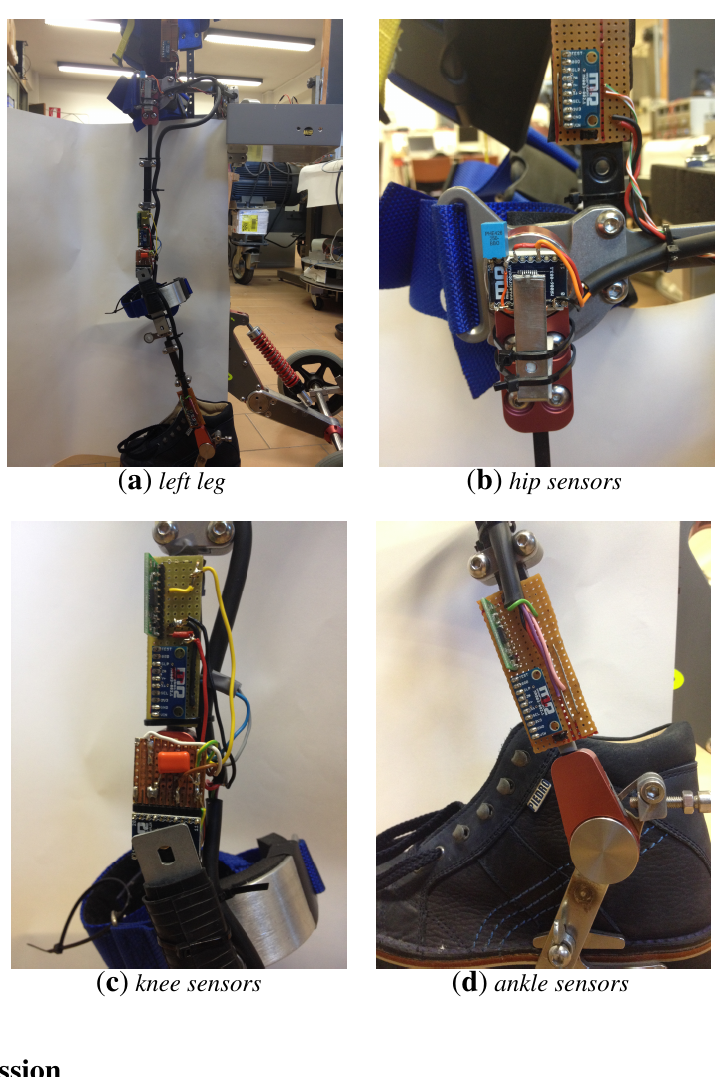
Figure 3. ( a ) Left leg of the modified commercial device for assisted gait (NF-Walker) used in the experiments; ( b ) particulars of the hip accelerometer and encoder; ( c ) particulars of the knee gyro, accelerometer and encoder; ( d ) particulars of the ankle gyro and